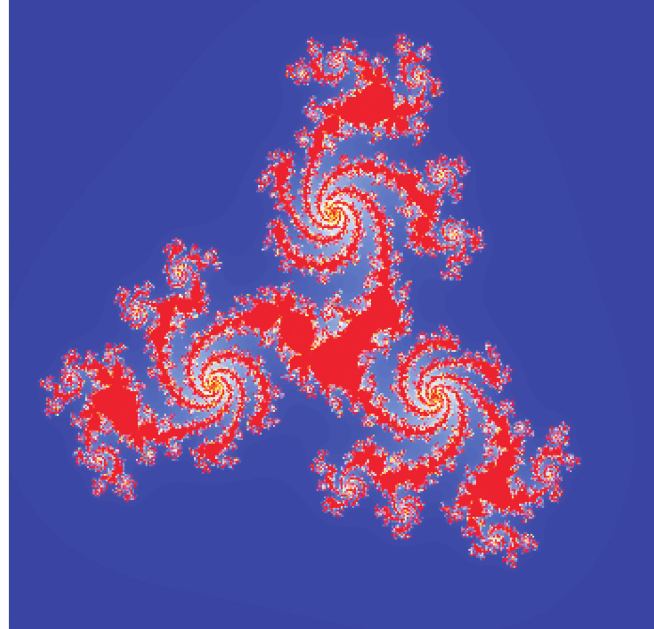
Figure 11: Cubic Julia set in